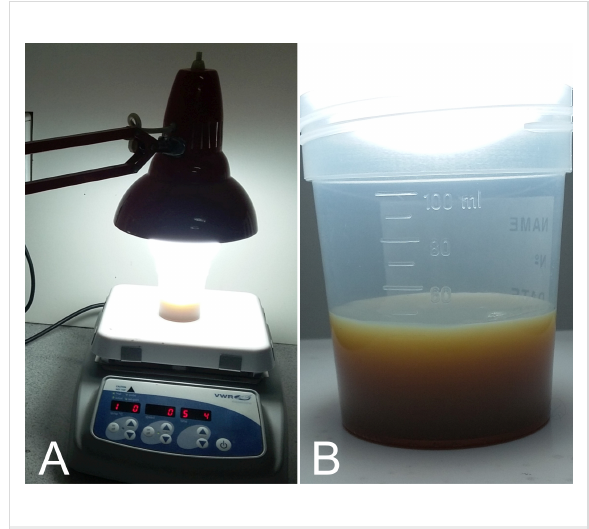
Figure 1: (A) Picture showing the experimental arrangement for the synthesis of Cl-AgNPs. A desk lamp with an LED bulb was placed above the beaker containing the reaction mixture. (B) Picture of the colloidal solution of Cl-AgNPs obtained after 10 min of light